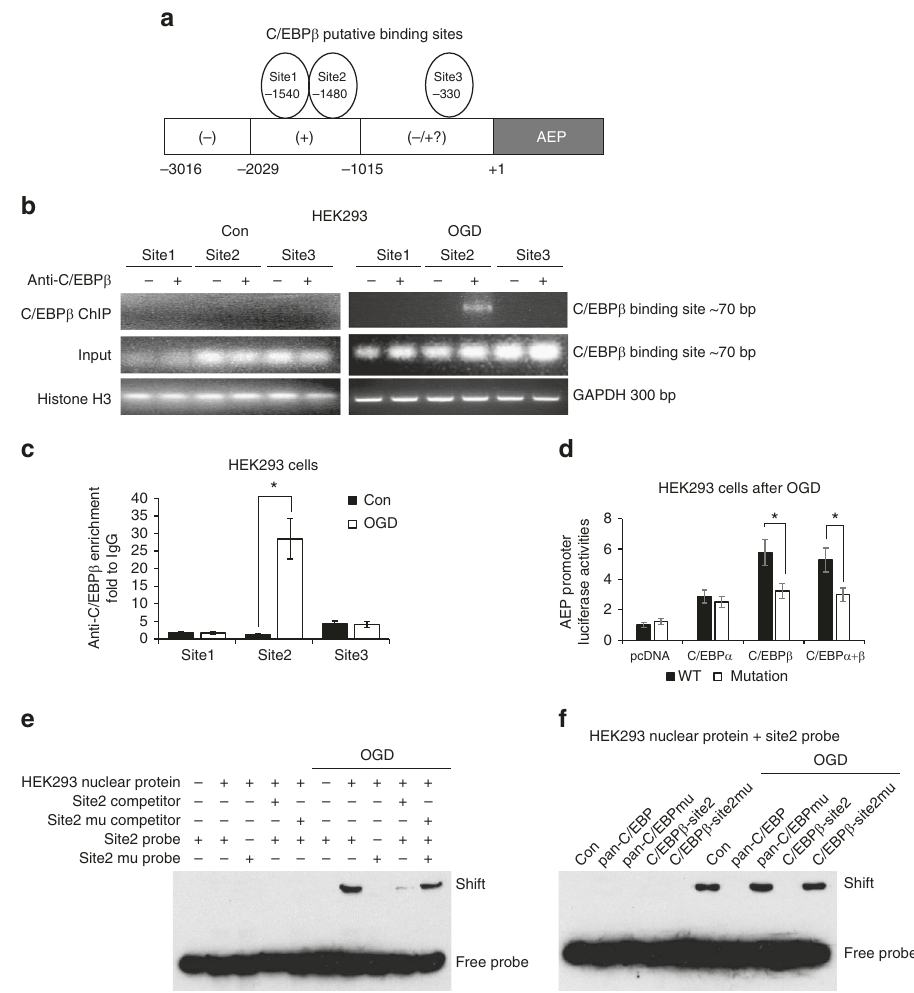
Fig. 2 C/EBP β binds to delta-secretase promoter and regulates its transcription. a The model of C/EBP β putative binding sites on human AEP promoter. b , c ChIP assay was performed to detect the binding sites of C/EBP β on the AEP promoter. The DNA-protein crosslinking ChIP samples from HEK293 cells treated with OGD or not, were immunoprecipitated with anti-C/EBP β antibody or IgG. After reversing crosslinks, PCR ( b ) and real-time PCR ( c ) were performed by using primer pairs at − 1540 (site 1), − 1480 (site 2), and − 330 (site 3) of the human AEP promoter. PCR assay also detected each input sample ( b ). The positive control PCR experiment was done by using anti-Histone H3 antibody and GAPDH primers ( b ). In real-time PCR analysis, the anti- C/EBP β enrichment was represented by the fold of C/EBP β antibody enriched target DNA comparing to IgG enriched ( c , * P < 0.05, Student ’ s t -test). d HEK293 cells were transfected with pcDNA, C/EBP α , and/or C/EBP β , as well as human AEP promoter luciferase reporter plasmid ( − 2029 to + 3) or its mutation (Site 2 was mutant). Forty-eight hours later, OGD/reperfusion was performed and then promoter activities were determined by luciferase assay (* P < 0.05, Student ’ s t -test). e Nuclear proteins were isolated from HEK293 cells received OGD/recovering treatment or not. EMSA assay was recruited to detect the C/EBP β binding ability increasing on Site 2 of AEP promoter after OGD/reperfusion treatment. f HEK293 cells were transfected with pan-C/EBP decoy DNA or its mutation, and Site2 decoy DNA or its mutation. Forty-eight hours later, cells were treated with OGD/recovering or not. EMSA assay